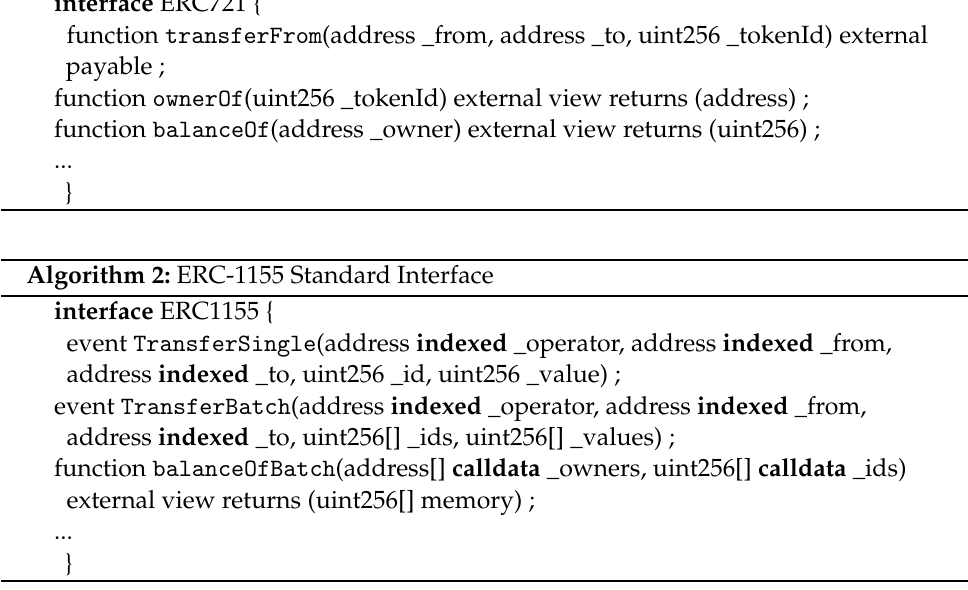
Algorithm 1: ERC-721 Standard Interface interface ERC721 {